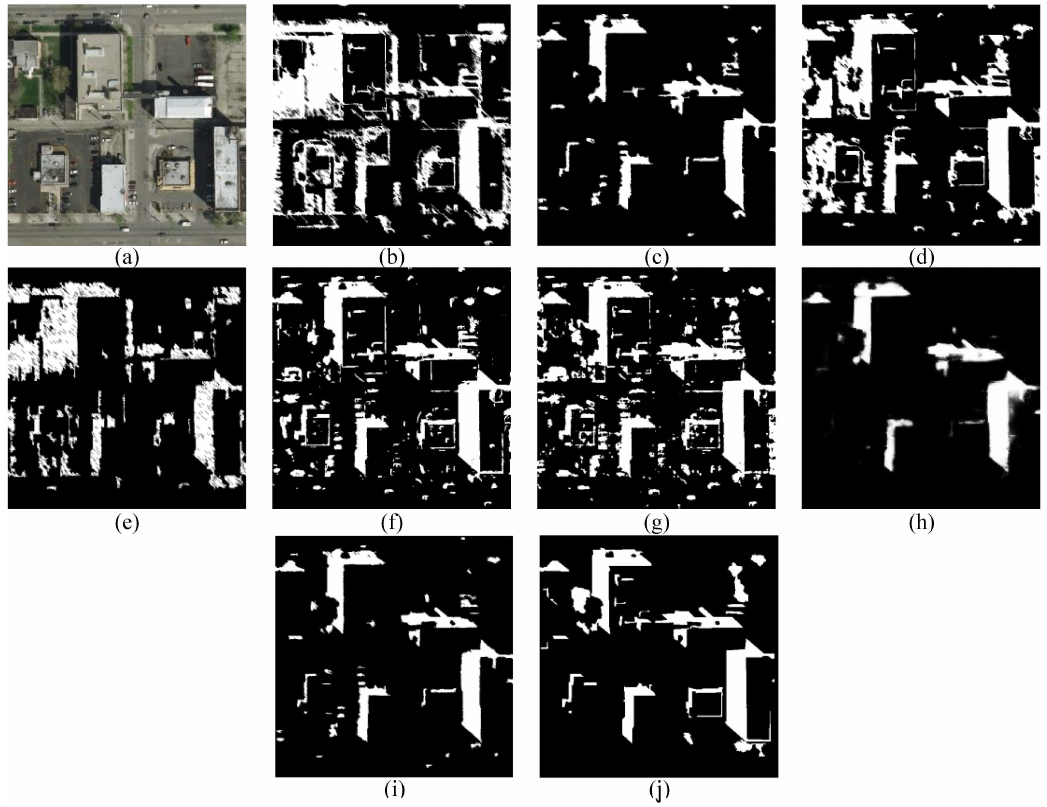
Figure 8. ( a ) Original image; ( b ) SRHI; ( c ) NB; ( d ) HTD; ( e ) C1C2C3; ( f ) U-Net method; ( g ) Segnet method; ( h ) BDRAR method; ( i ) DLA-PSO method; ( j ) ground